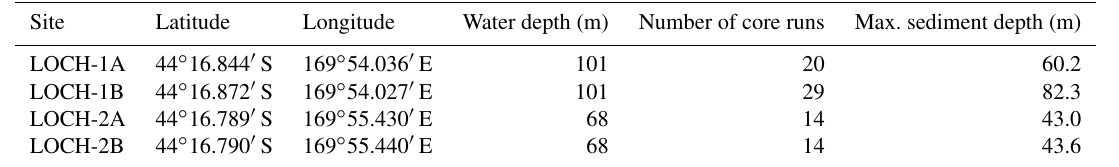
Table 1. Drill site location data and core information.